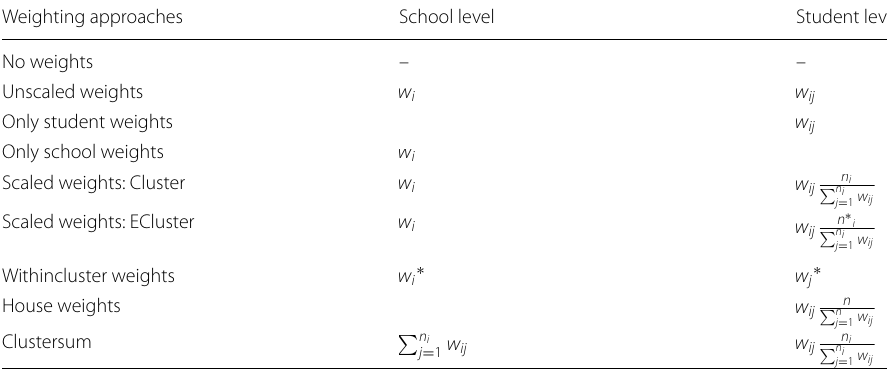
Table 4 Weighting approaches for the simulation study and their application and formulas for the different levels of the